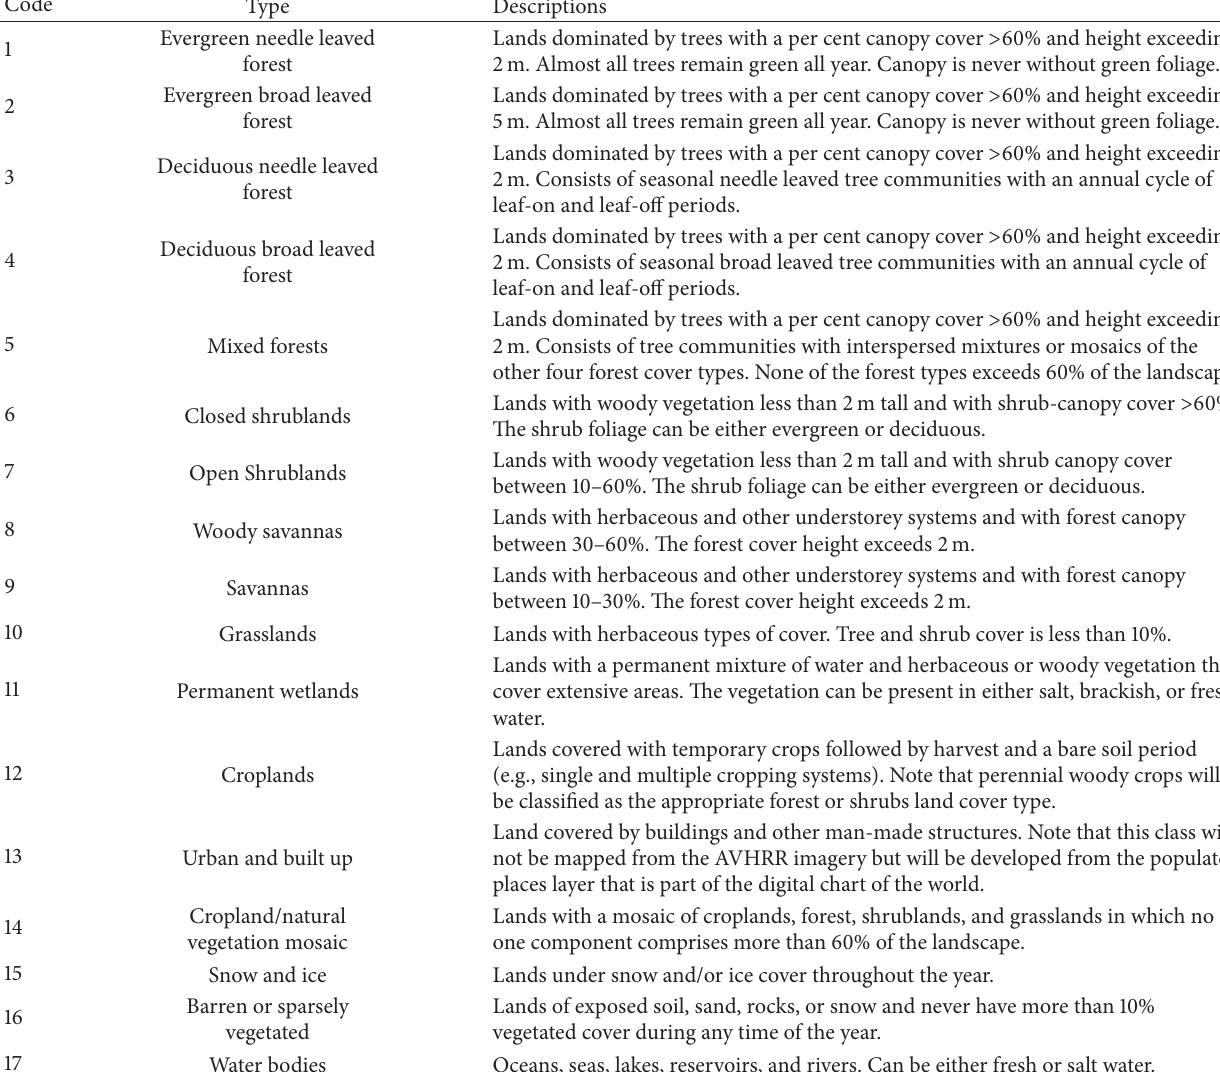
Table 1: Types and descriptions of IGBP land cover classification